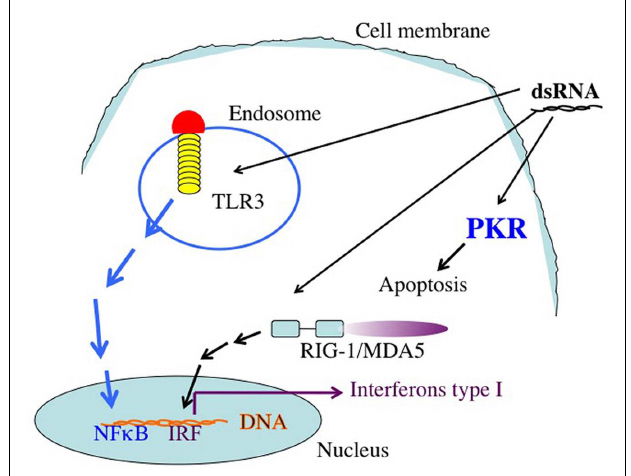
FIGURE 1 |The targets of dsRNA. TLR3 recognizes dsRNA extacellularly or in endosomal compartments.TheTLR3TIR domain is associated with the adaptor moleculeTRIF, which upon ligation activates the protein kinases TBK-1 and IKKe. IRF-3 is phosphorylated byTBK-1 and IKKe on C-terminal serines, leading to its dimerization and translocation into the nucleus. Active IRF-3 induces transcription from the IFN- β promoter. Intracellular dsRNA is recognized by the RNA helicase RIG-I (or MDA5), which activatesTBK-1 and IKKe via its CARD domain, leading to IRF-3 activation as well. Both pathways also activate NF κ B by mechanisms that are not fully understood yet. Secreted IFN- β binds to the IFN receptor (IFNR) leading to transcriptional activation of ISGs (interferon stimulated genes), such as IRF-7. IRF-7 further stimulates transcription from the IFN- α and - β promoters in a positive feedback loop. In addition to these targets, which are responsible for the activation of the immune system dsRNA binds to the enzyme dsRNA dependent protein kinase, PKR.The activation of PKR leads to the phosphorylation of the eIF2a, leading to the inhibition of protein translation.